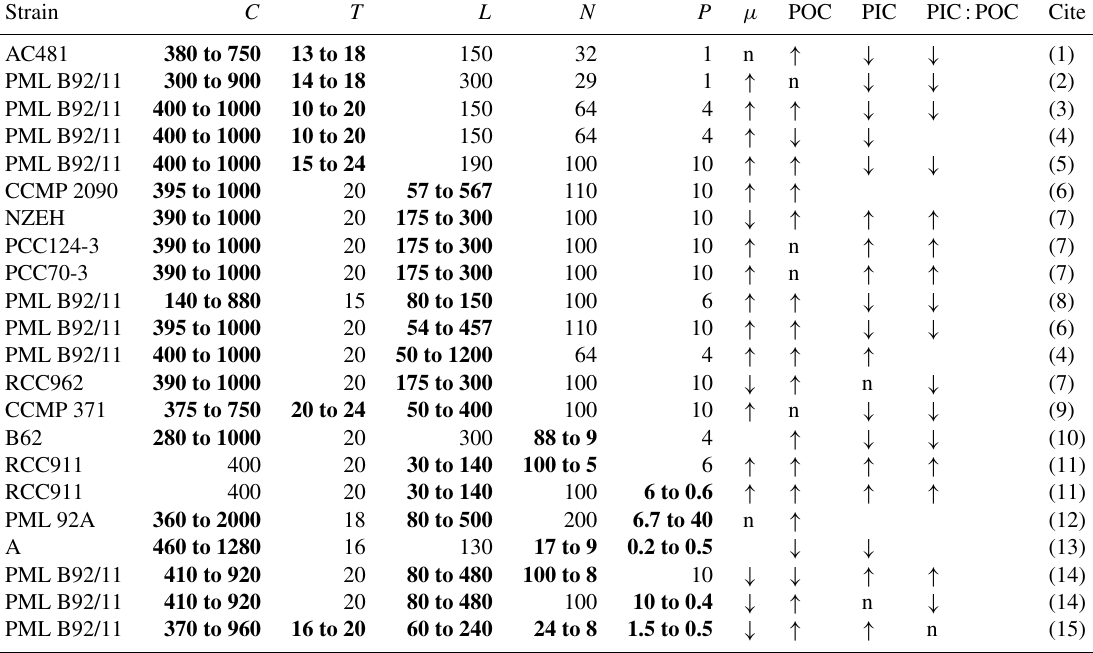
Table 5. List of the physiological responses of E. huxleyi to the concurrent changes in multiple drivers investigated by the laboratory incu- bations in the published studies. “ ↑ ” represents increase, “ ↓ ” represents decrease, and “n” represents no significant change regarding simul- taneous changes in multiple drivers. C , T , L , N , P and µ represent CO 2 (µatm), temperature ( ◦ C), light intensity (µmolphotonsm − 2 s − 1 ), dissolved inorganic nitrogen and phosphate (µmolL − 1 ), and growth rate, respectively. Simultaneous changes in multiple drivers are marked in